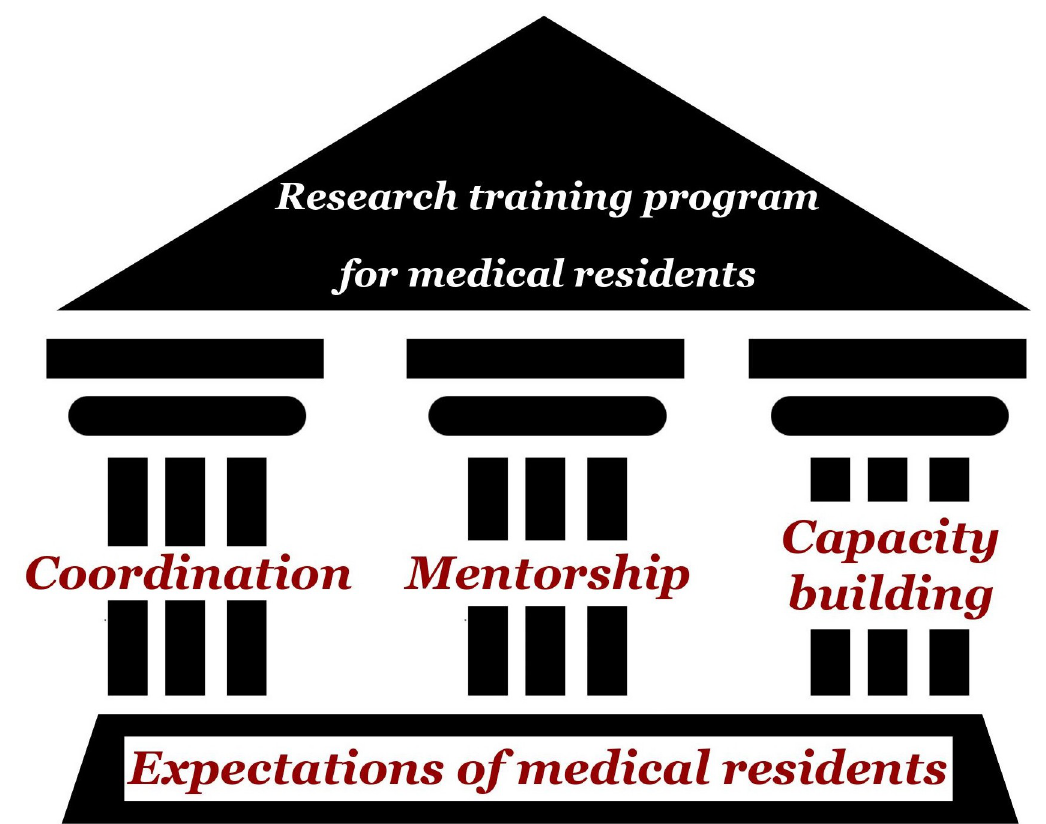
Fig 2. Schematic representation of the four emerging